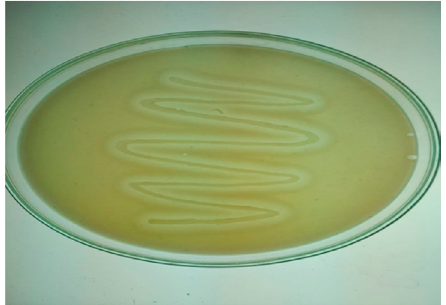
Fig. 1. Plate showing zone around isolated Table 3. Effect of Incubation periods on lipase production Incubation Bacillus Serratia